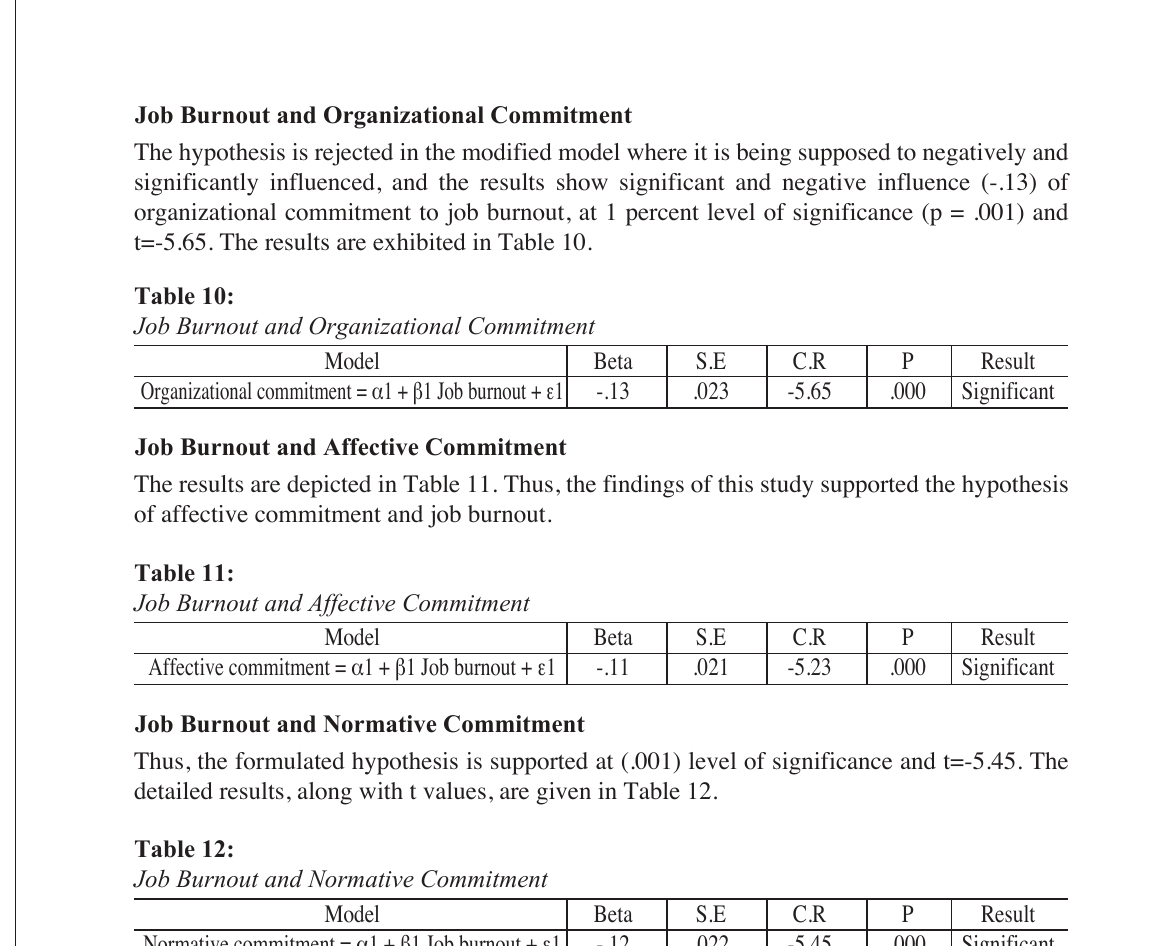
Job Burnout and Normative